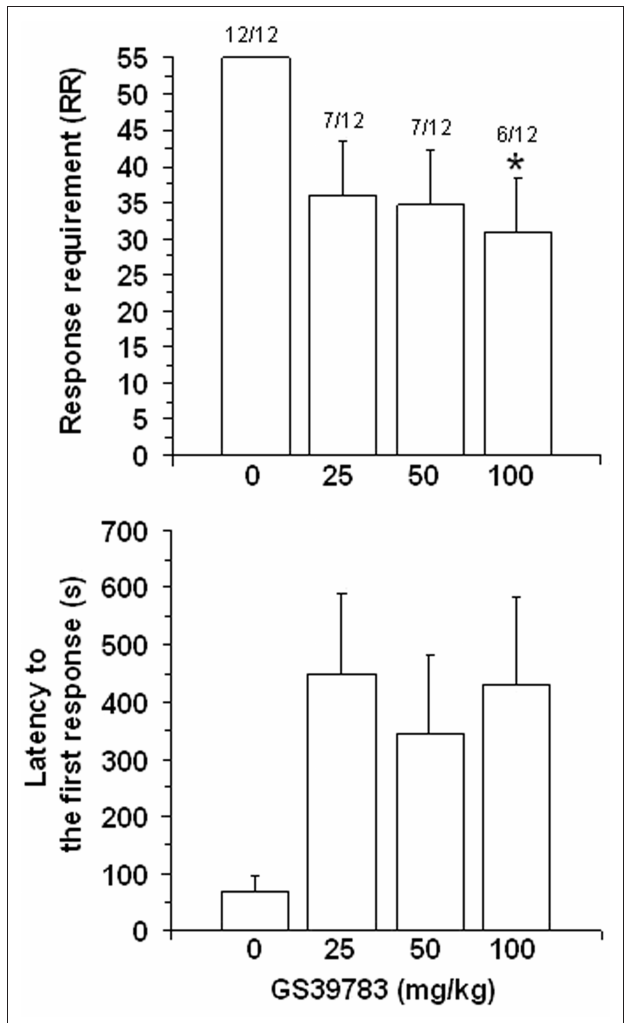
Figure 2 | effect of pretreatment with different doses (administered intragastrically) of the positive allosteric modulator of the gABA gS39783, on two measures of alcohol-taking behavior [amount of self-administered alcohol (top panel) and number of licks on the sipper spout (bottom panel)] in selectively bred Sardinian alcohol-preferring (sP) rats trained to self-administer alcohol under the “sipper” procedure. Specifically, each daily session comprised two temporally distinct phases: in the first phase (alcohol-seeking), rats were required to lever-respond up to RR55 to access alcohol; in the second phase (alcohol-taking), rats that had previously achieved RR55 were exposed for 20 min to the alcohol (15%, v/v)-containing sipper bottle. Each bar is the mean ± SEM of n = 12 rats. ∗ P < 0.01 and ∗∗ P < 0.001 with respect to vehicle-treated rats (Newman–Keuls